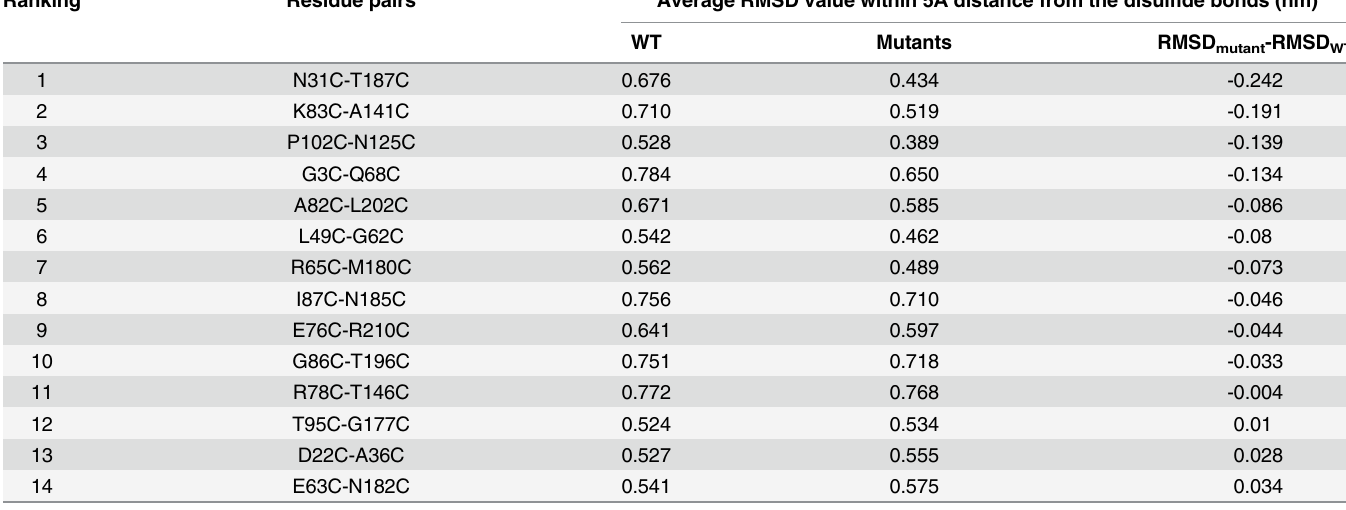
Table 1. Comparison of the average RMSD values in the mutant regions (within 5 Å distance from the disulfide bonds) between wild-type BglTM and the mutants.